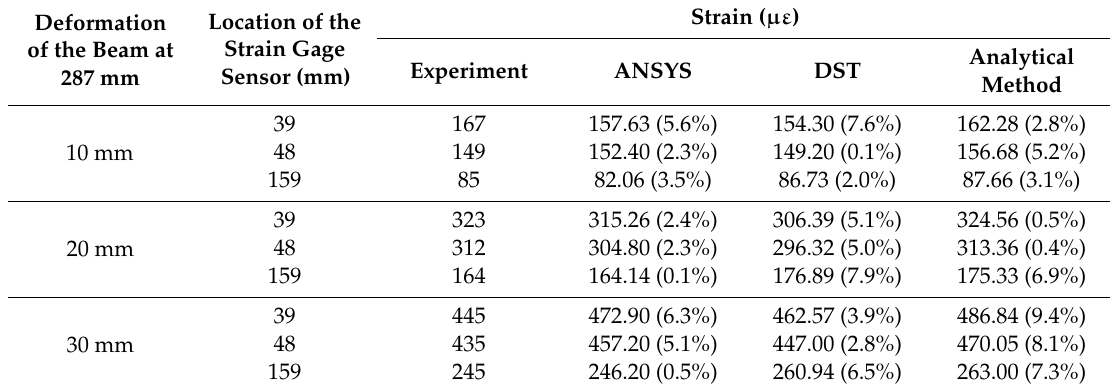
Table 4. Strain estimation results using the DST matrix (Single material).